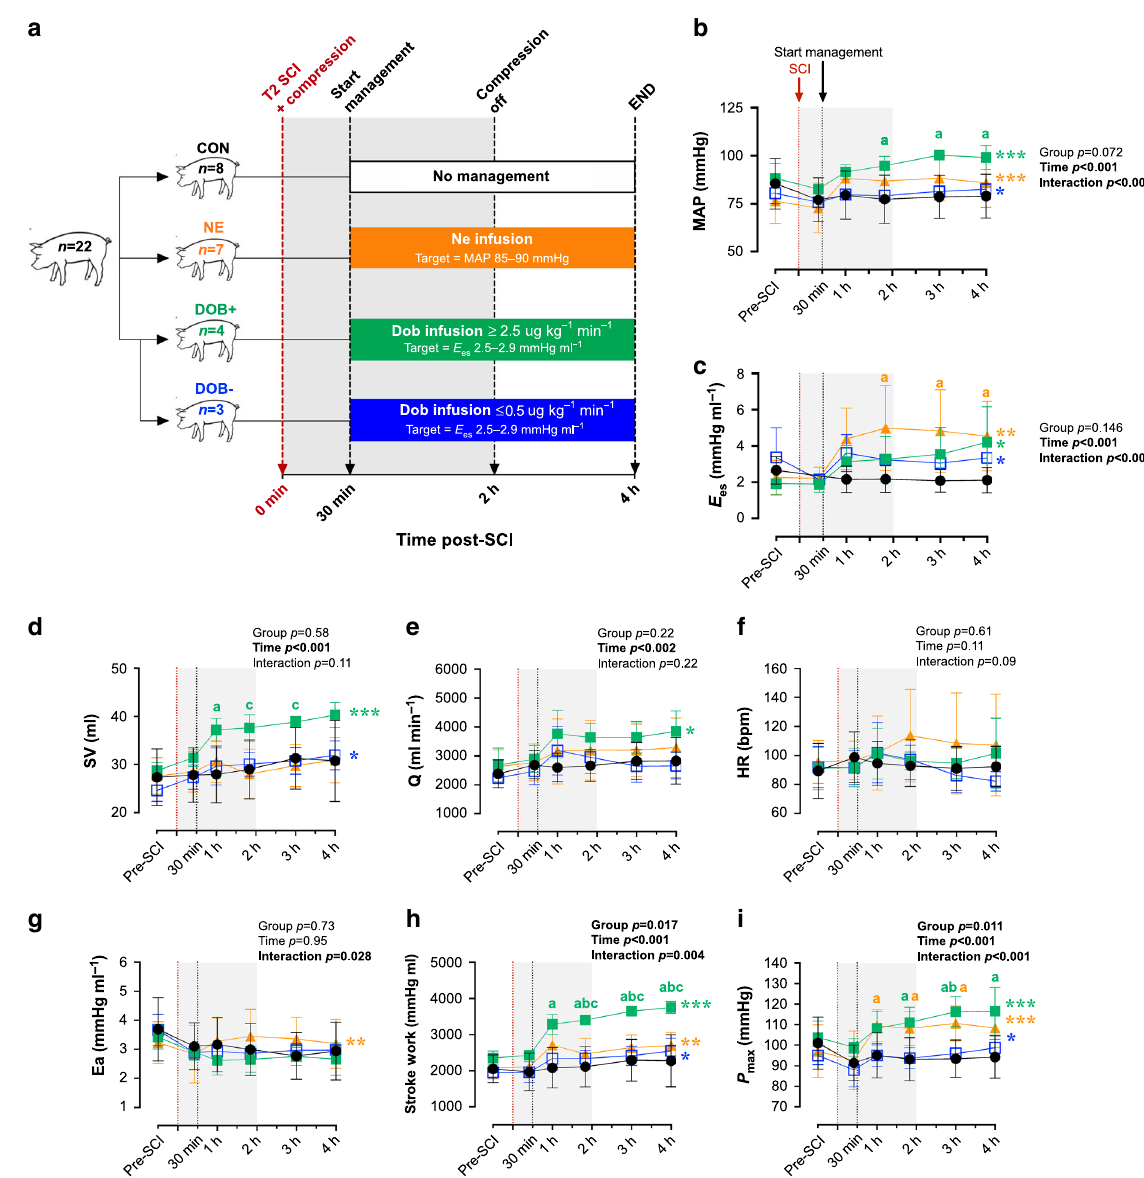
Fig. 3 Impacts of dobutamine (DOB) and norepinephrine (NE) on LV function and hemodynamics in acute T2 SCI. Dependent variables from 30 mins (i.e. start of hemodynamic management) to 4 h post-SCI were analyzed using a two-way repeated-measures ANOVA (factors: time, group), and post hoc comparisons were made with Tukey ’ s test (between-group) and Fisher ’ s LSD (within-group compared to 30 mins post-SCI). a Following experiment 1 (control [CON], closed circles; n = 8), an additional n = 14 animals received hemodynamic management starting 30 mins post-SCI with either DOB (squares, n = 7) titrated to a target E es of ~2.5 – 2.9 mmHgml − 1 , or NE (triangles; n = 7) titrated to a mean arterial pressure (MAP) of 85 – 90 mmHg. Three animals receiving DOB had a relatively high baseline E es , and as a result received minimal doses of DOB (i.e., ≤ 0.5 μ g kg − 1 min − 1 , DOB-, open squares; n = 3) while n = 4 animals received substantial DOB doses (i.e., ≥ 2.5 μ g kg − 1 min − 1 , DOB + , closed squares). b Data points are means and error bars represent s.d. Both DOB + and NE augmented MAP, however MAP was signi fi cantly elevated in DOB + compared to CON animals. c LV contractility, E + generated increases in LV stroke volume (SV) and e cardiac output (Q), which were not observed es , was augmented by both DOB and NE. d Only DOB with NE. f There were no signi fi cant changes to heart rate (HR) with hemodynamic management, nor were there differences between the groups. g LV afterload increased with NE management but not with DOB. h Stroke work, an index of systolic function, is only increased with DOB + , i despite increases to P max in both NE and DOB. * p < 0.05, ** p < 0.01, *** p < 0.001 (within-group effect for time). a p < 0.05 vs CON; b p < 0.05 vs DOB-; c p < 0.05 vs NE. Within-group comparisons between 30 mins and 1 h to 3 h post-SCI are available in Supplementary Tables 3 – 5. Source data are provided as a Source Data fi